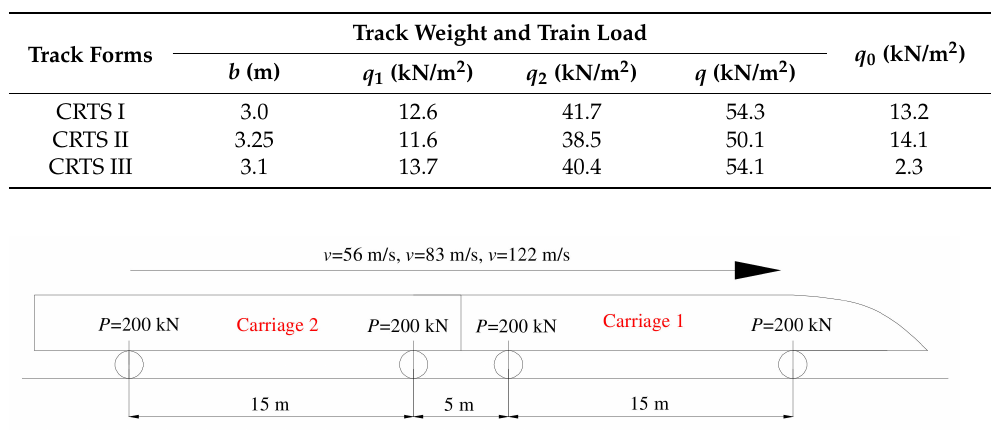
Figure 3. Distribution of vertical load in the code design. Note: q 0 is the line load; q 1 is the track weight; q 2 is the train load; q is the total load; b is width of the track load; b 0 is the width of uniform load for backfilling between two lines. Table 2. Uniform loads induced by the track and train.